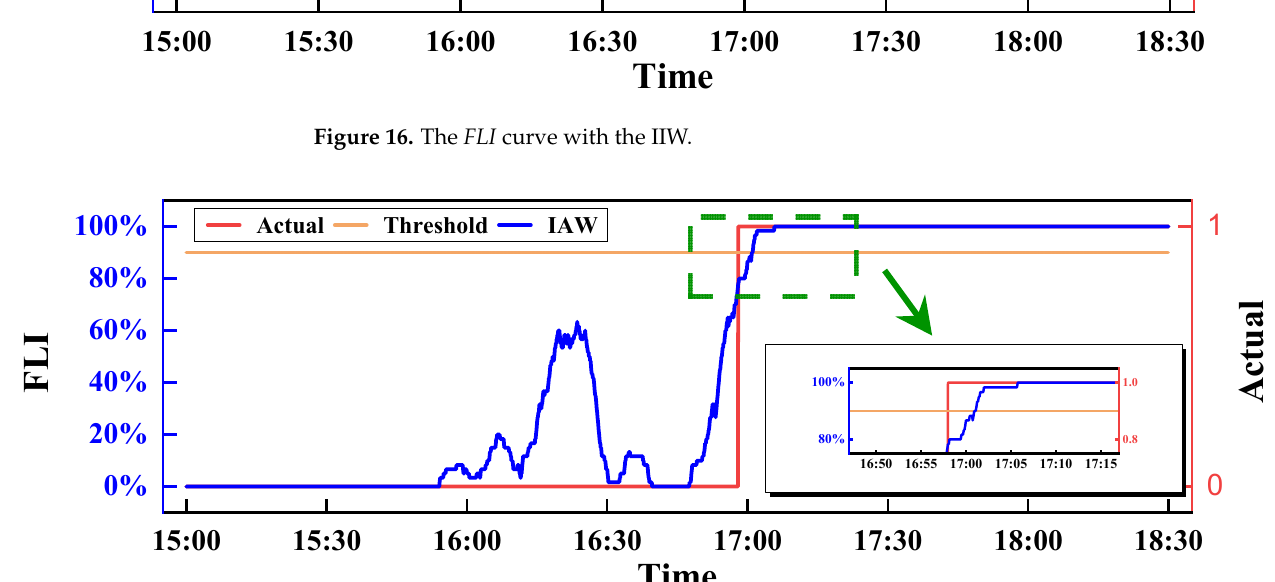
Figure 17. The FLI curve with the IAW.